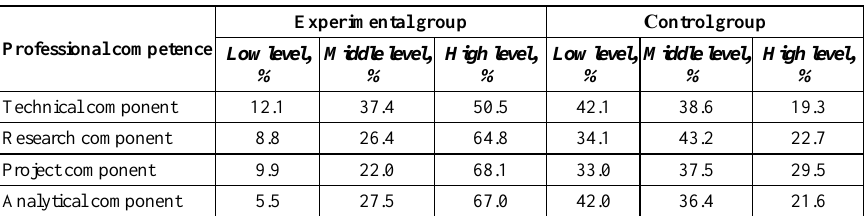
Table 2. Level of professional competence in the experimental and control groups at the end of the